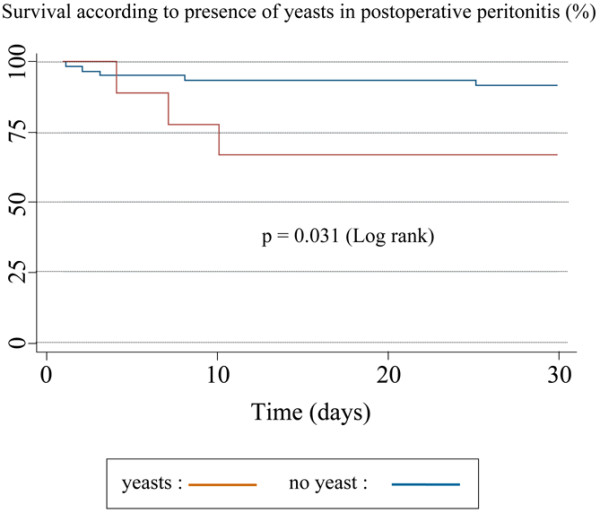
Survival according to presence of yeasts in postoperative peritonitis.